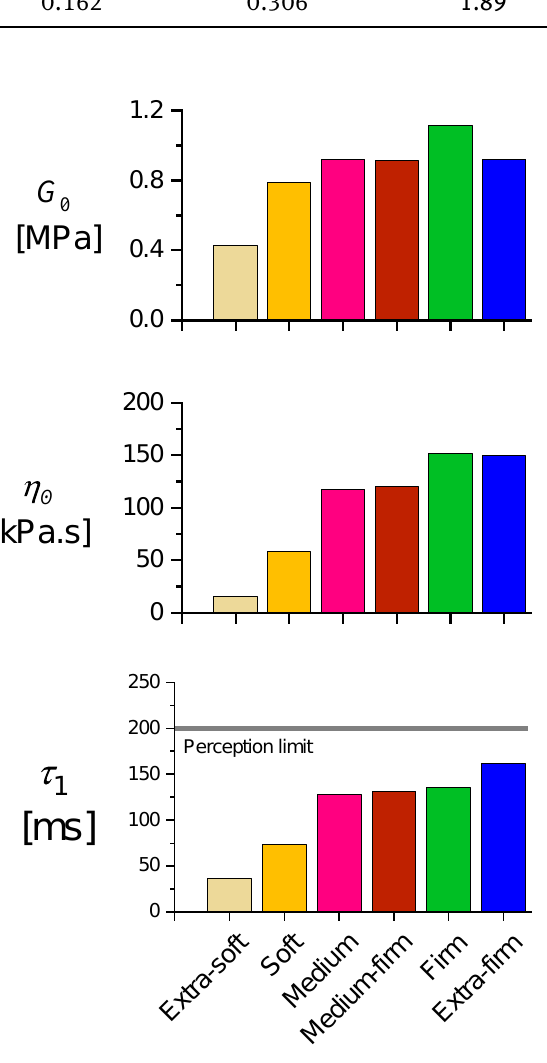
Figure 11: The difference felt between putties is primarily the viscos- ity η 0 , not the elastic modulus G 0 or relaxation timescale τ 1 . The low dimensional descriptions are calculated from moments of the relaxation spectra. Only a small difference in elastic nature is ob- served while an order of magnitude change is observed across the viscous description. There is significant difference in the relaxation timescale, however these timescales are well below the estimated limits of active perception outlined in Table